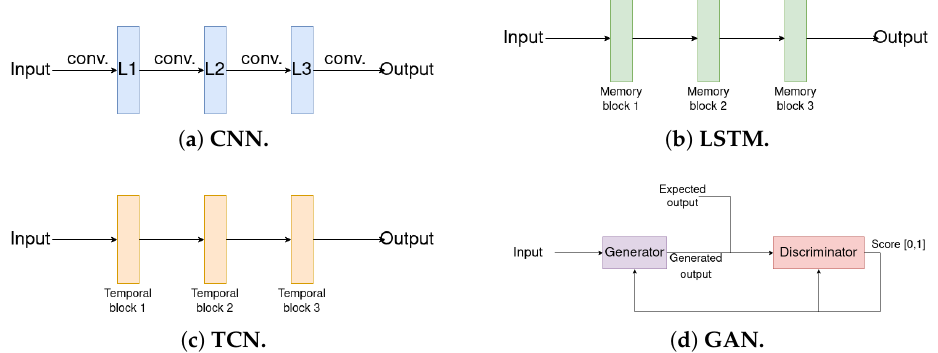
Figure 1. Schematics of some Deep Learning network architectures: ( a ) Convolutional Neural Network (CNN) model with three convolutional layers; ( b ) Long Short-Term Memory (LSTM) model with three memory blocks (a schematic of a memory block can be seen in Figure 2); ( c ) Temporal Convolutional Network (TCN) model with three temporal blocks (a schematic of a temporal block can be seen in Figure 3a); ( d ) Generative Adversary Network (GAN) model with a generator and a discriminator. The output of the discriminator is a score, where 0 shows that the expected output and generated output are completely different and 1 shows that the generated output is the same as the expected